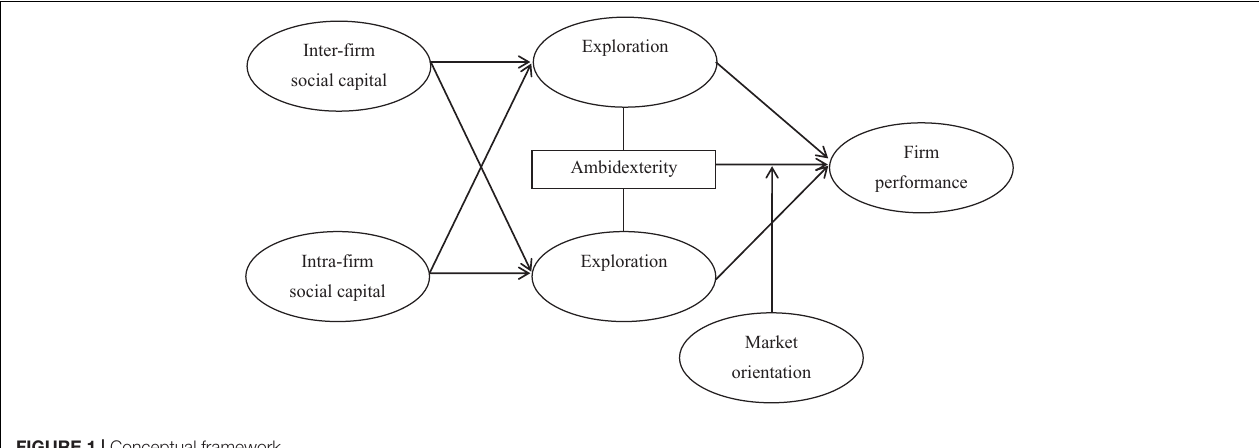
FIGURE 1 | Conceptual framework.